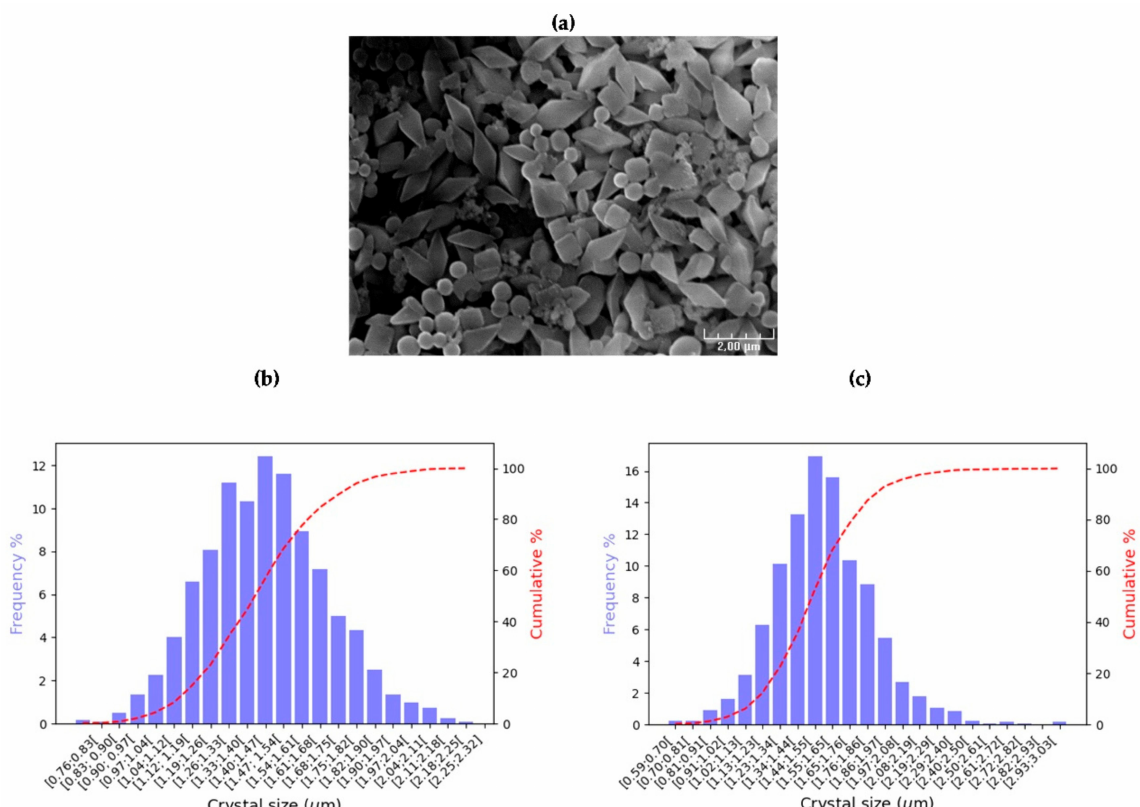
Figure 2. ( a ) SEM image of the HD1 purified crystals. ( b , c ) Graphs representing the size distribution in terms of frequency, along with the cumulative percentage of the bipyramidal height for the bipyramidal crystals and the cubic size of the cubic